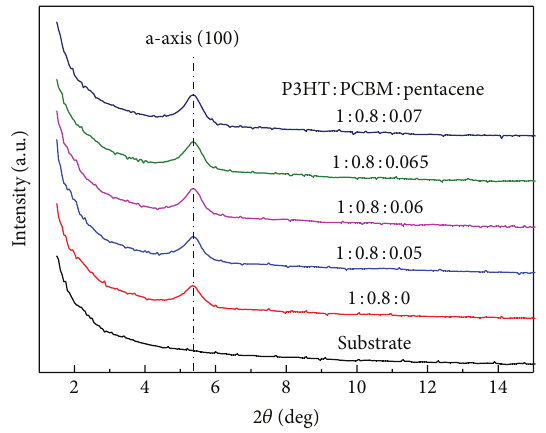
Figure 5: XRD spectra of the absorption layers with various pentacene doping contents.